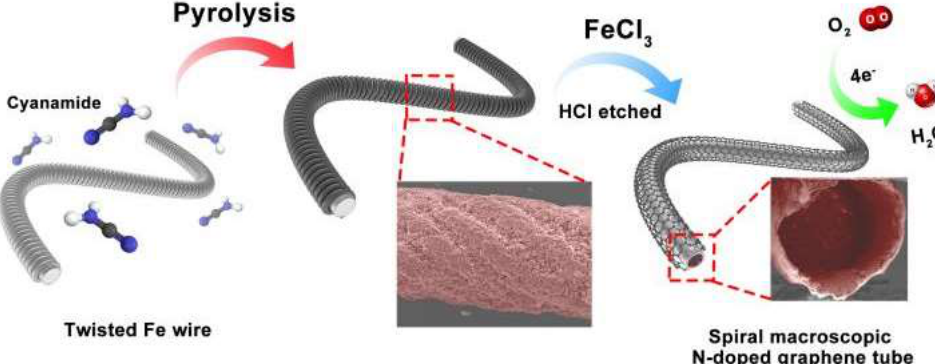
Scheme 1. Schematic illustration of the procedure for the spiral macroscopic N-doped graphene tube decorated carbon nanotubes and N-Fe particles from a solid carbon and nitrogen source.